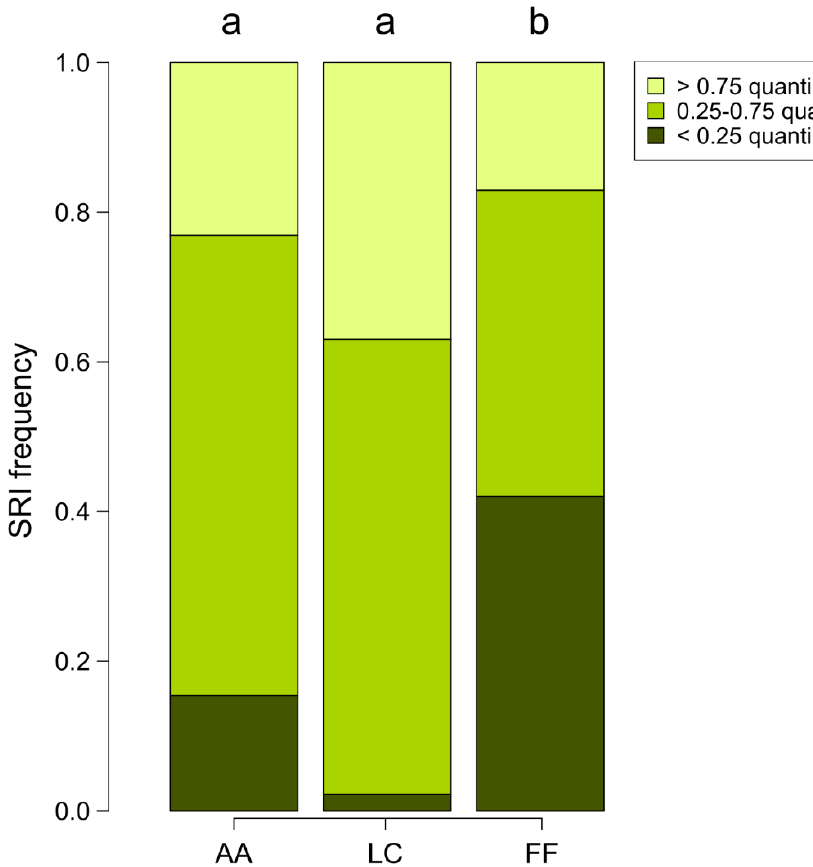
Figure 4. Barplot of the frequency distribution of the SRI index (height of the nest divided by the mean width of its base) in the three sites. AA: Avorniolo Alto, fir-dominated forest; LC: Le Cullacce, mixed forest; and FF: Fosso Fresciaio, beech-dominated forest. Letters above bars represent the significance of multiple comparison tests.